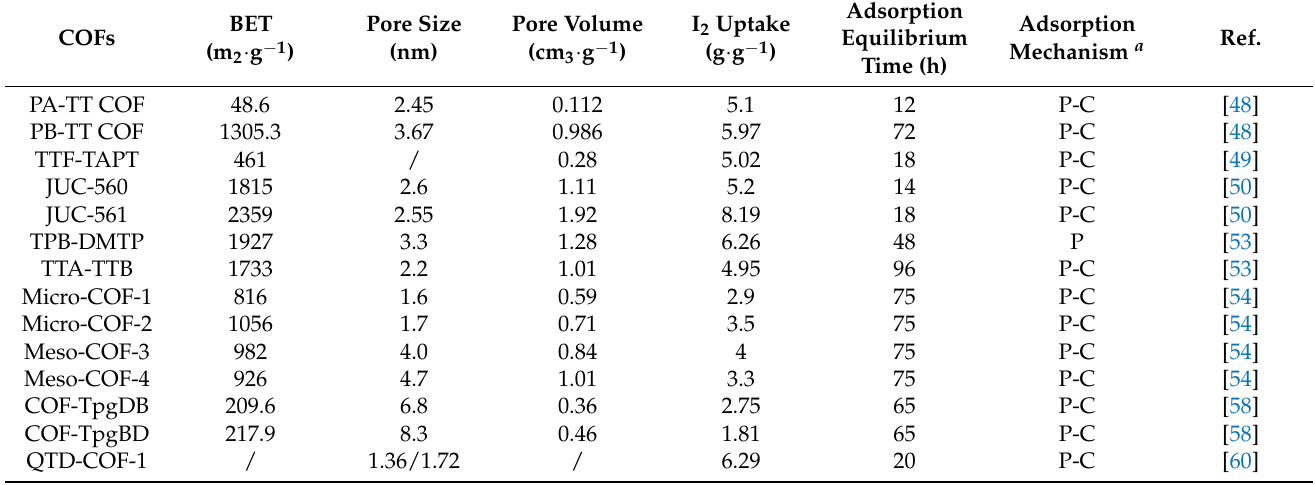
Table 1. Some structural features and adsorption properties of volatile I 2 (348~350 K and 1 bar) of the reported